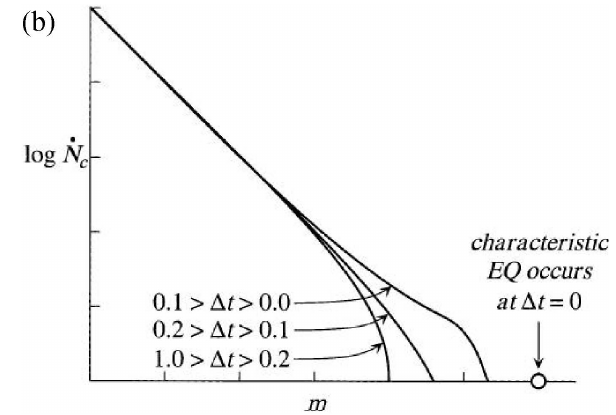
Fig. 1b. The hypothesis of seismic activation for characteristic earthquakes by Rundle et al. (2000). The x-axis is cut-off mag- nitude, m, and the y-axis is cumulative number of earthquakes which magnitudes are larger than or equal to corresponding m. 1t is a timely ratio measured from the occurrence of a next char- acteristic earthquake. We have 1t = 1 . 0 just after a character- istic earthquake, and the next characteristic earthquake occurs at 1t = 0. Three 1t stages are indicated from down to up: sys- tematic lack of intermediate-sized earthquakes, a continuous in- crease of intermediate-sized earthquakes and a further increase of intermediate-sized